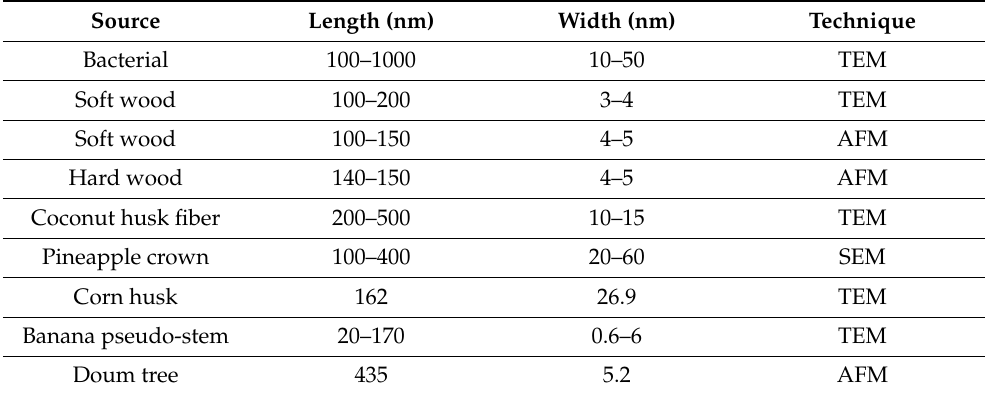
Table 2. Examples of CNs with the length (L) and width (w) from cellulosic sources measured by different